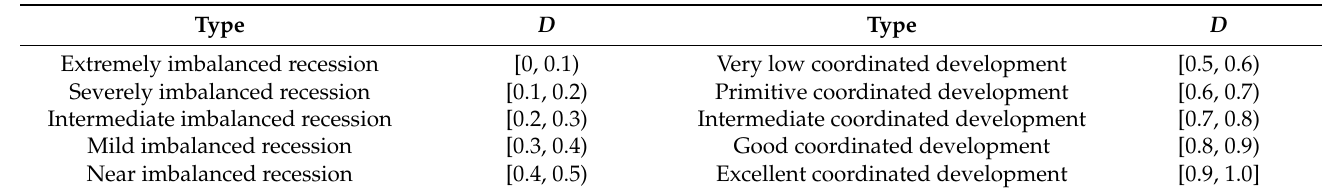
Table 2. The classification of coordination degree in regard to farmland transfer and